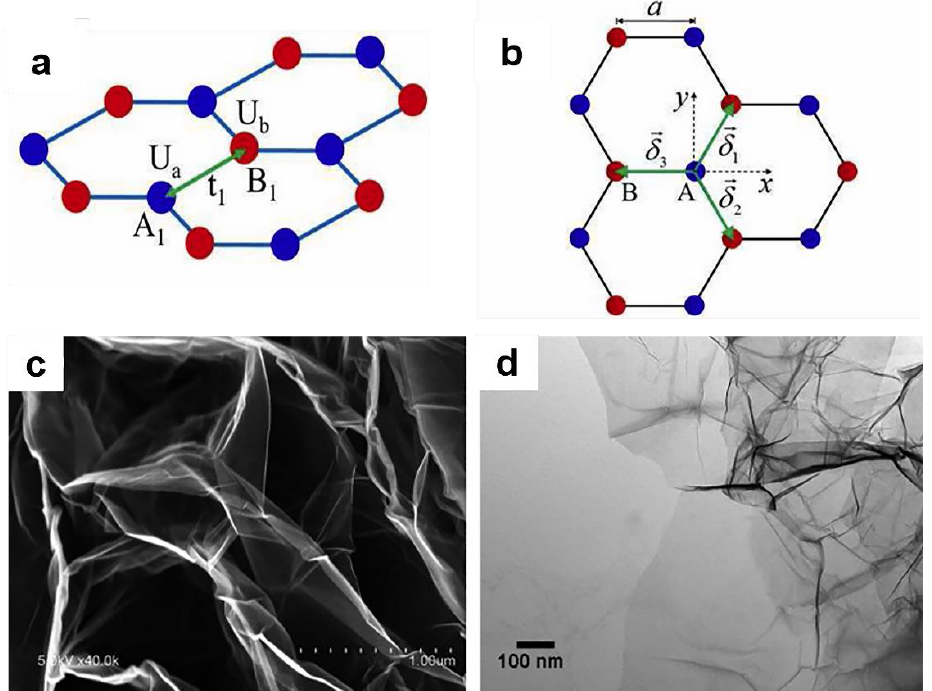
Figure 6. ( a ) and ( b ) Single-layer graphene lattice [56]. Copyright © 2021 Elsevier Ltd. and Solid State Communications. ( c ) SEM images and ( d ) TEM images of graphene [57]. Copyright © 2021 Published by Elsevier B.V. and Applied Surface Science.